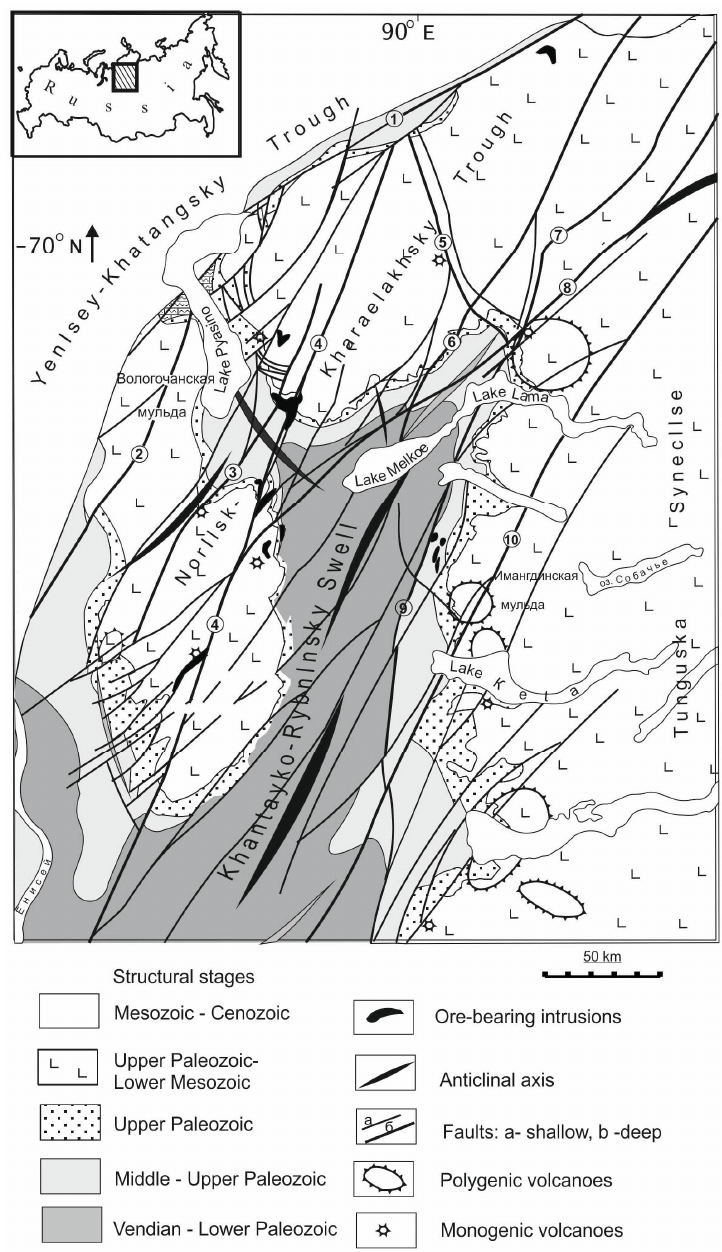
Figure 1. Tectonic schema of the Norilsk area (constructed by Mikhailov and authors based on a geological map of the Norilsk area [62]). Faults, number: 1—North-Kharaelaksky, 2—Pysinsky, 3—